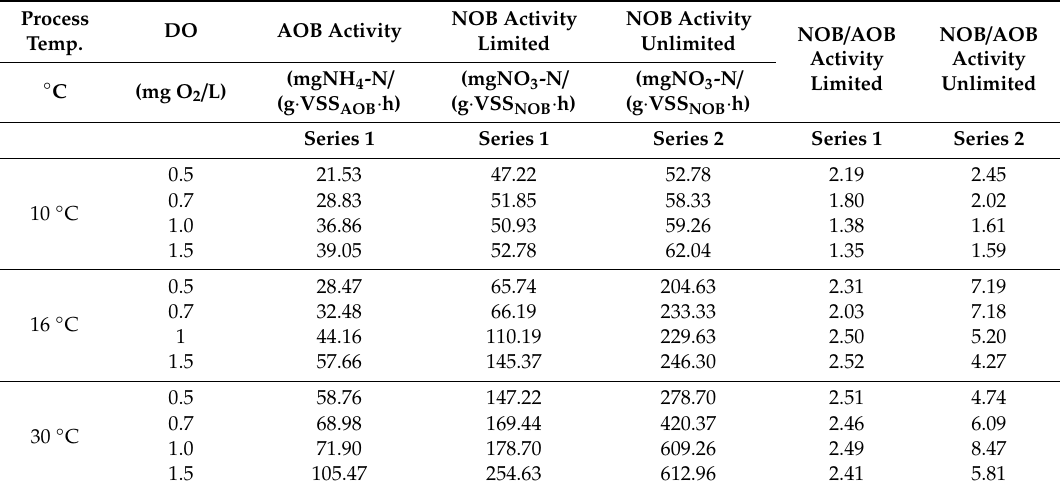
Table 4. The normalized activity of the AOB and NOB after relation to actual abundance in the applied biomass samples under the defined temperature and DO set